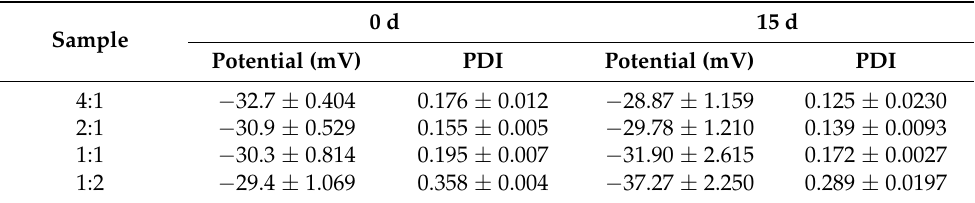
Figure 4. The redispersibility of zein/SC, zein/CA, and zein/SC/CA composite NPs. Table 1 lists the average potential and PDI value of CA-loaded composite NPs with different mass ratios of zein/SC when stored for 0 and 15 days. The zeta potential increased after 15-day storage for composite NPs with the mass ratios of zein/SC were 4:1 and 2:1, while it decreased for composite NPs with the mass ratios of zein/SC were 1:1 and 1:2. The potential value changed the most for the mass ratio of zein/SC was 1:2, showing a fall from − 29 mV to − 37 mV. Such a phenomenon was mainly attributed to more carboxylate being exposed on the outer surface of the particles after storage. PDI value was usually used to characterize the particle size distribution of suspension, and a lower PDI indicated a more uniform particle size distribution. By comparing the changes in PDI values of the dispersions at 0 d and 15 d, it can be found that the PDI values of the four groups of dispersions decreased to different degrees after 15 days, indicating the better distribution uniformity of composite NPs in the dispersions during the standing. In short, the composite NPs with the mass ratio of zein/SC was 1:2, the storage stability was the best. The particle size had nearly no change during the standing, and the stability was better as well. Table 1. The CA-loaded composite NPs with different mass ratios of zein/SC of average potential and PDI values, after storage for 0 and 15